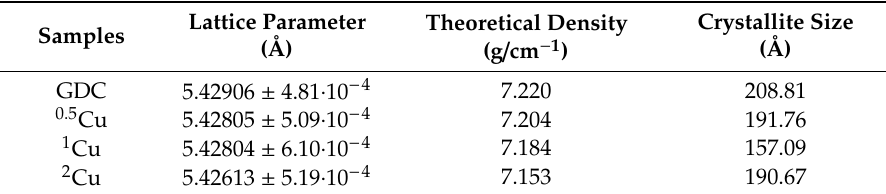
Table 2. Composition of electrolyte powders